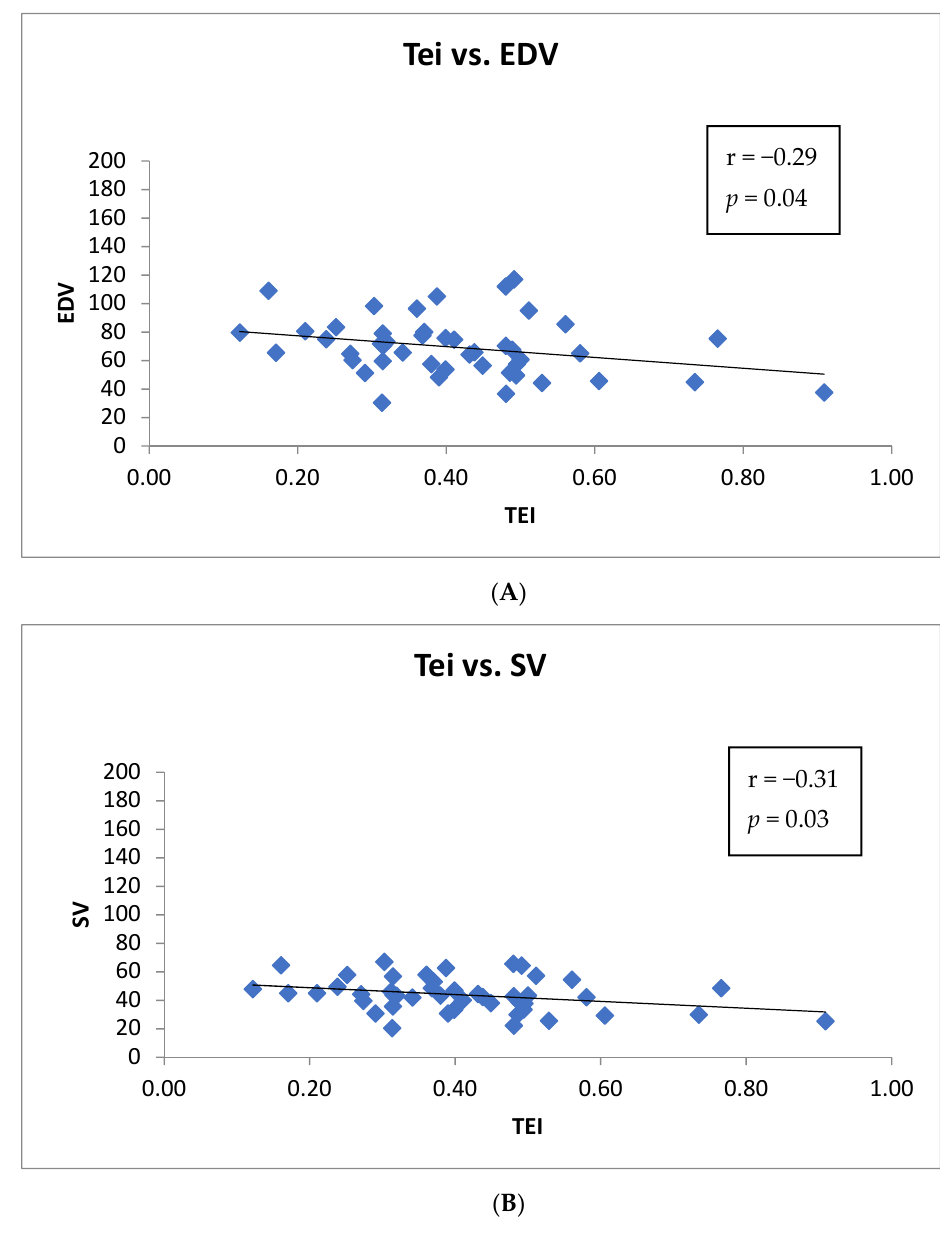
Figure 2. ( A ) Correlation between the Tei index value and the end diastolic volume (EDV) after the first cycle of chemotherapy in all patients (Tei- and Tei+). ( B ) Correlation between Tei index value and stroke volume (SV) after the first cycle of chemotherapy in all patients (Tei- and Tei+).